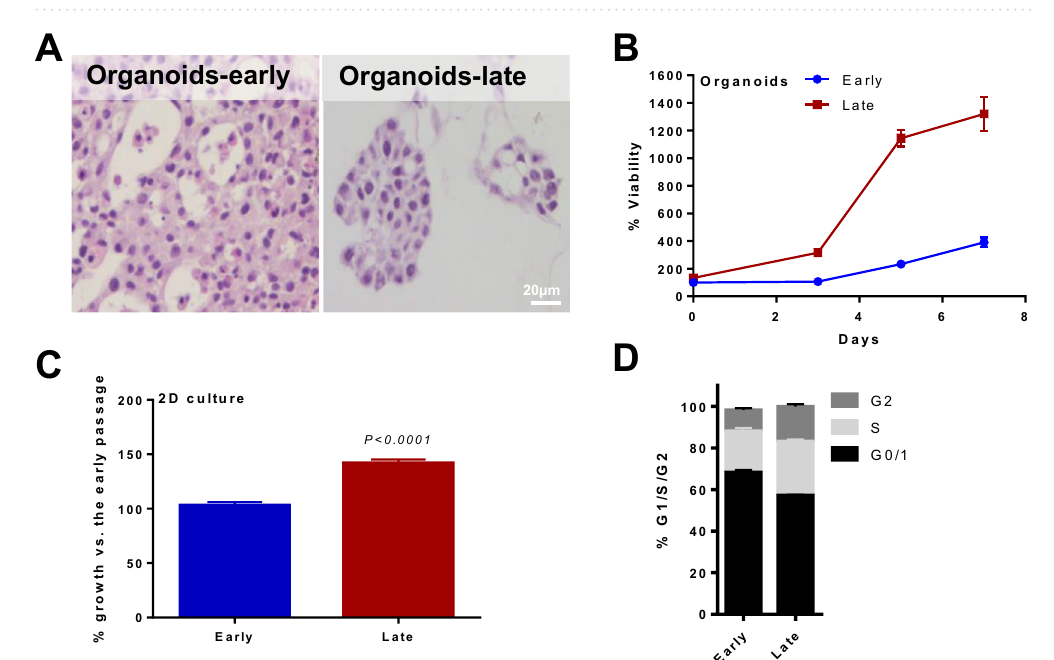
Figure 3. CoCaB 1 PDX-derived organoids reproduce CoCaB 1 PDX progressive growth phenotypes. ( A ) Representative IHC staining showing conserved high-grade urothelial carcinoma histology in early and late passage organoids. Magnification 200x. Scale bar represents 20 µm. ( B , C ) Late passage ( B ) organoids (s2 early, s9 late; n = 4–8) and ( C ) cultured cells (s2 early, s10 late; n = 6) grow faster than early passage organoids and cells. ( D ) In organoids, late passages display an increase proportion of cells in the S phase of the cell